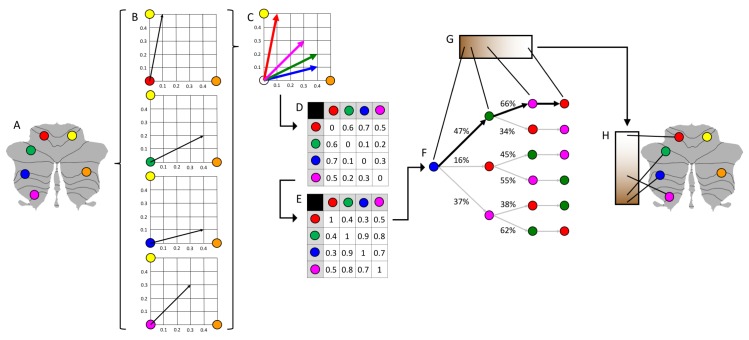
Schematic representation of diffusion map embedding.(A) This example presents a schematic representation of diffusion map embedding. It illustrates the calculation of the principal functional gradient of 4 cerebellar voxels (red, green, blue, magenta) based on their functional connectivity with two target cerebellar voxels (yellow, orange). (B) Connectivity from each cerebellar voxel (red, green, blue, magenta) to the two target cerebellar voxels (yellow, orange) is represented as a two-dimensional vector. (C) All vectors can be represented in the same two-dimensional space. (D) Cosine distance between each pair of vectors is calculated, and (E) an affinity matrix is constructed as (1-cosine distance) for each pair of vectors. This affinity matrix represents the similarity of the connectivity patterns of each pair of voxels. (F) A Markov chain is constructed using information from the affinity matrix. Information from the affinity matrix is thus used to represent the probability of transition between each pair of vectors. In this way, there will be higher transition probability between pairs of voxels with similar connectivity patterns. This probability of transition between each pair of vectors can be analyzed as a symmetric transformation matrix, thus allowing the calculation of eigenvectors. (G) Eigenvectors derived from this transformation matrix represent the principal orthogonal directions of transition between all pairs of voxels. Here we illustrate the first resulting component of this analysis – the principal functional gradient of our four cerebellar voxels (red, green, blue, magenta) based on their connectivity with our two target cerebellar voxels (yellow, orange) progresses from the blue, to the green, to the magenta, to the red voxel. (H) This order is mapped back into our cerebellum map, allowing us to generate functional neuroanatomical descriptions. Of note, our cerebellar functional gradients were calculated using functional connectivity values of each cerebellar voxel with the rest of cerebellar voxels (rather than between four voxels and only two target cerebellar voxels, as in this example). Vectors in our analysis thus possessed many more than just two dimensions, but cosine distance can also be calculated between pairs of high-dimensional vectors. Diffusion map embedding using functional connectivity values from each cerebellar voxel to all cerebellar voxels thus captures the principal gradients of cerebellar functional neuroanatomy.